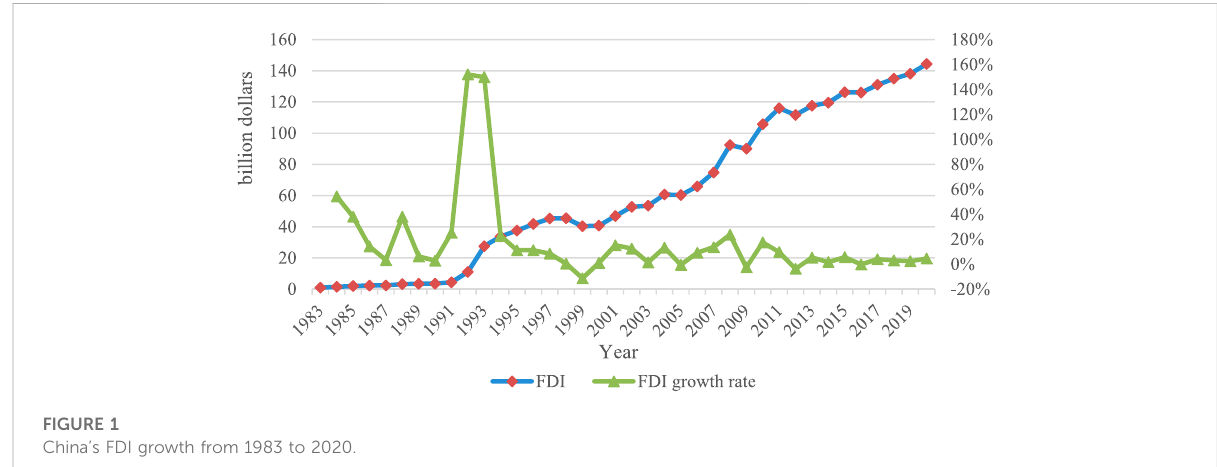
FIGURE 1 China ’ s FDI growth from 1983 to